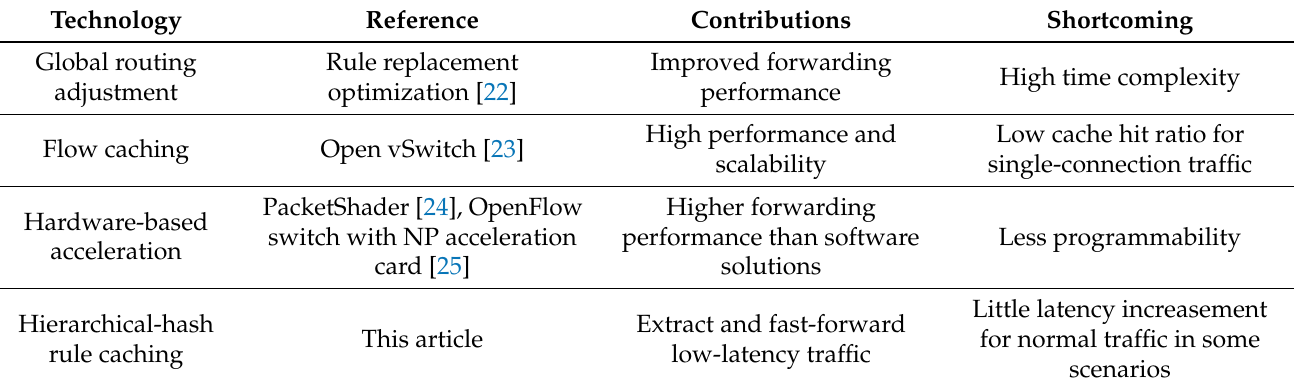
Table 1. Summary of approaches in the literature and our